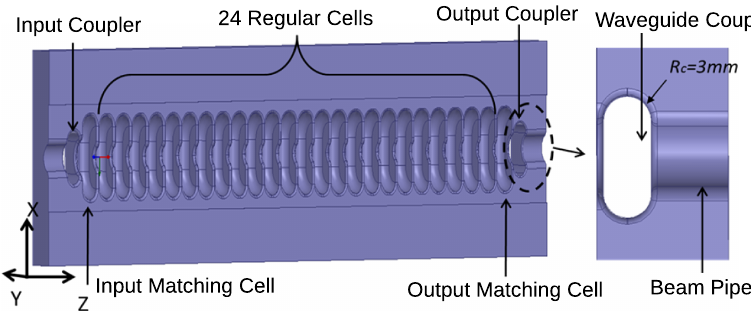
FIG. 7. CLIC-G-OPEN structure half with 24 regular cells and 2 matching cells. The waveguide coupler is also displayed on the right [11].